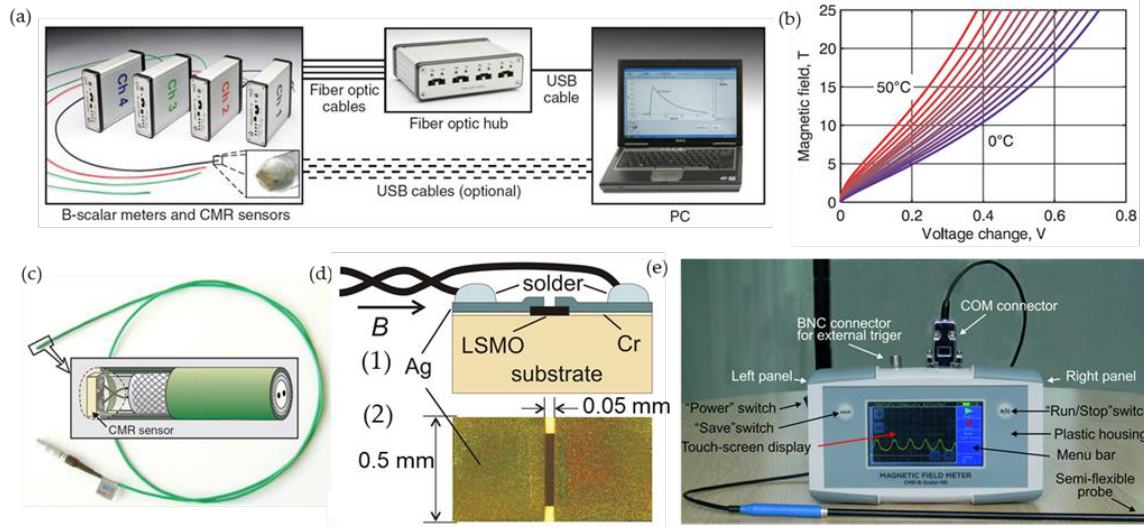
Figure 13. ( a ) The outside view and schematic diagram of four-channel pulsed magnetic field measurement system based on CMR-B-scalar sensors. Optic fiber cables are used for transfer recorded and stored in the channel signal to PC. ( b ) Family of calibration curves for a particular CMR-B-scalar sensor. ( c ) Schematic 3D cross section of the CMR-B-scalar sensor with cable (not to scale). Reprinted with permission from [10]. Copyright 2014 AIP Publishing. ( d ) Schematic drawing of the cross section of two-terminal sensor with bifilarly twisted wires (1) and its picture with two Ag electrodes before soldering wires (2). Reprinted with permission from [62], copyright 2012 IOP Publishing. ( e ) Outside view of a hand-held CMR-B-scalar-06 magnetometer with a color touch screen for a waveform display. The hand-held semiflexible probe is connected to the device. Reprinted with permission from [98]. Copyright 2020 IEEE.